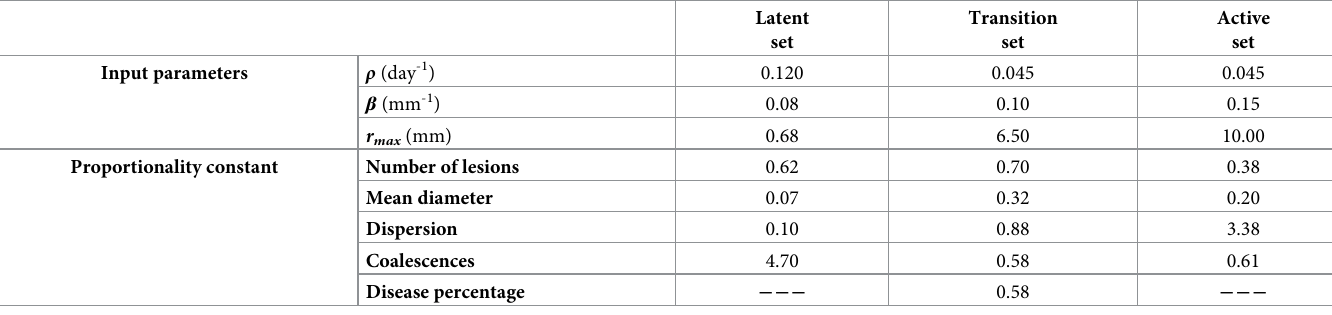
Table 3. Values of proportionality constant, A ( OC , S ),for different outcomes and sets of input parameters.